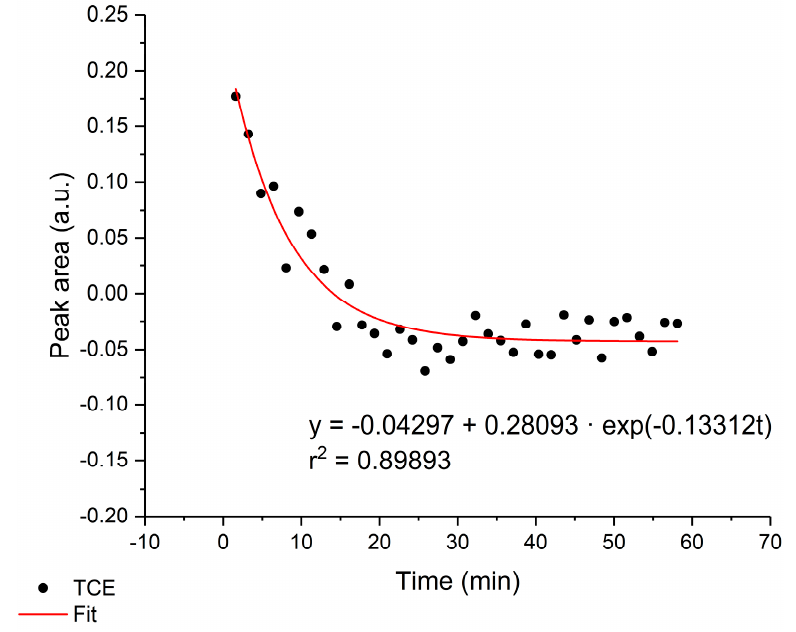
Figure 6. Exemplary regeneration process of TCE at 931 cm − 1 . The polymer layer was completely regenerated after approx. 20 min.